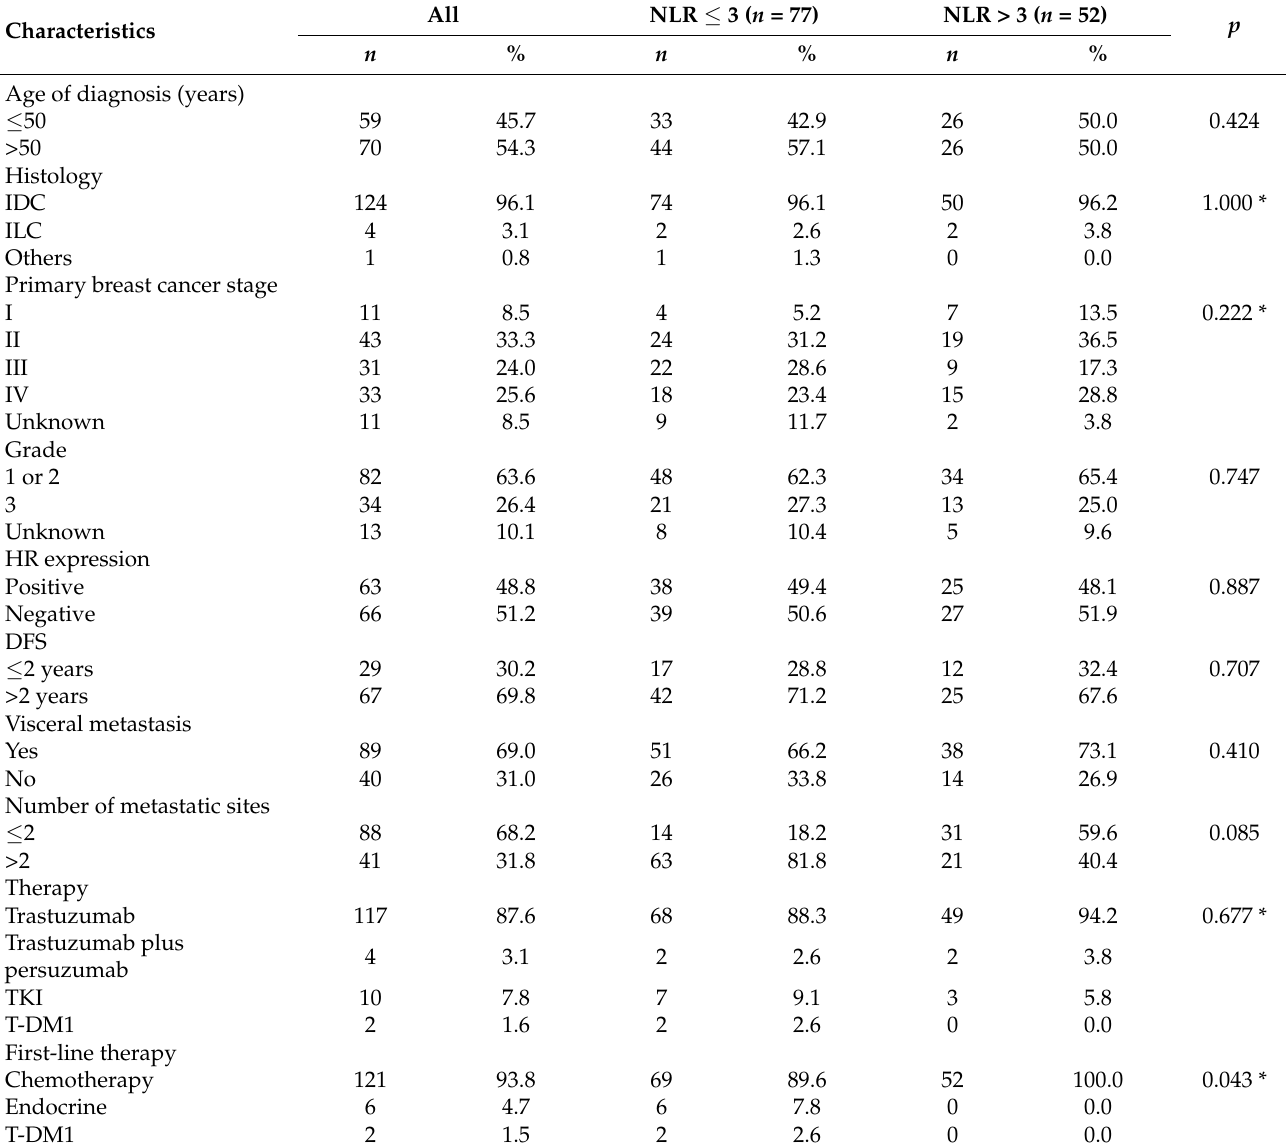
Table 1. Clinicopathological characteristics of 129 patients with HER2+